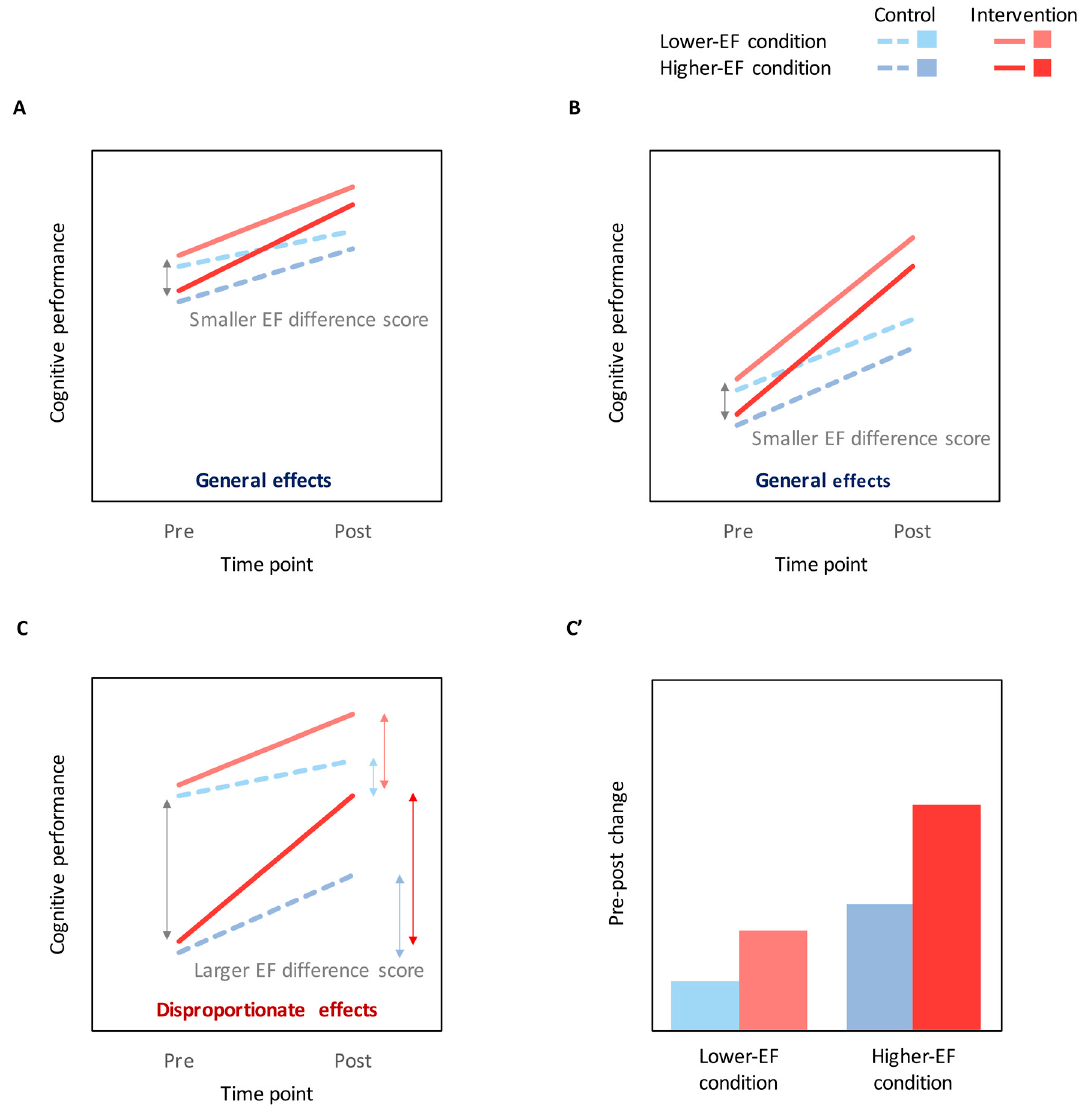
Figure 2. Conceptual diagrams of the prediction of changes in cognitive performance based on the baseline EF (executive function) di ff erence scores. ( A ) If baseline cognitive performance is relatively high in both the lower-EF and higher-EF conditions (i.e., smaller EF di ff erence score), cognitive improvements resulting from a PA intervention would be relatively small in the both EF conditions, resulting in the general e ff ects of PA on cognitive performance irrespective of EF conditions. ( B ) If baseline cognitive performance is relatively low in the both EF conditions (i.e., smaller EF di ff erence score), cognitive improvements resulting from a PA intervention would be relatively large in the both EF conditions, resulting in the general e ff ects. ( C ) If the baseline EF di ff erence score is su ffi ciently large, cognitive improvements resulting from a PA intervention would be greater for the higher-EF condition relative to the lower-EF condition, resulting in the disproportionate e ff ects. Colored double-headed arrows show pre–post changes in cognitive performance (i.e., the present dependent variable) in each group and EF condition. ( C’ ) The line graph in ( C ) is converted to a bar graph using the pre–post changes in cognitive performance in accord with Figure 3B.